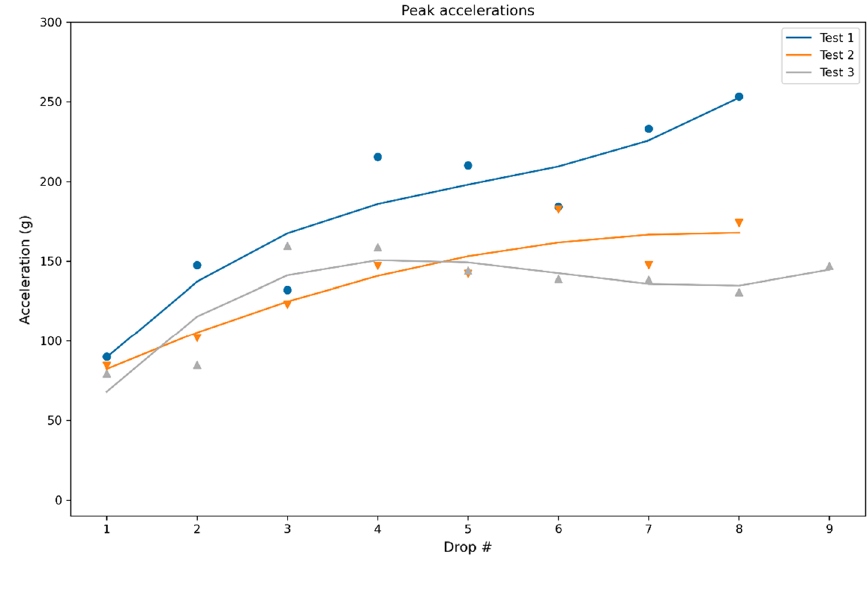
Fig. 10 Peak accelerations for three different drop sequences with P2 (495 g / 200 × 100 × 43 mm / 4–4-4 wrapping